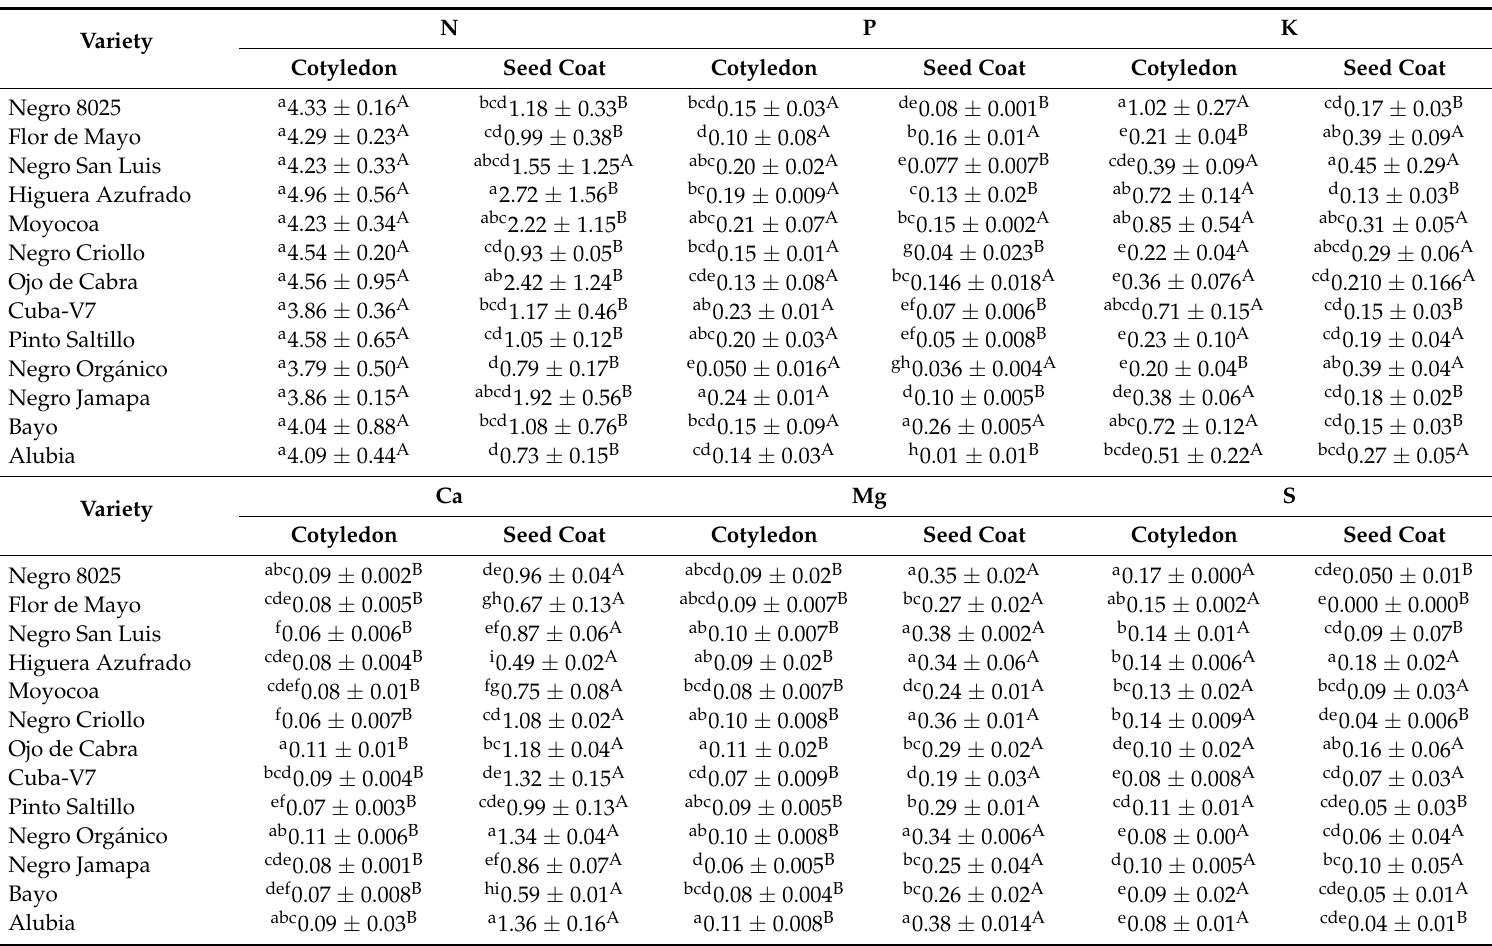
Table 6. Macronutrient content (%) in the seed coat and cotyledon of common bean varieties. N P K Variety Cotyledon Seed Coat Cotyledon Seed Coat Cotyledon Seed